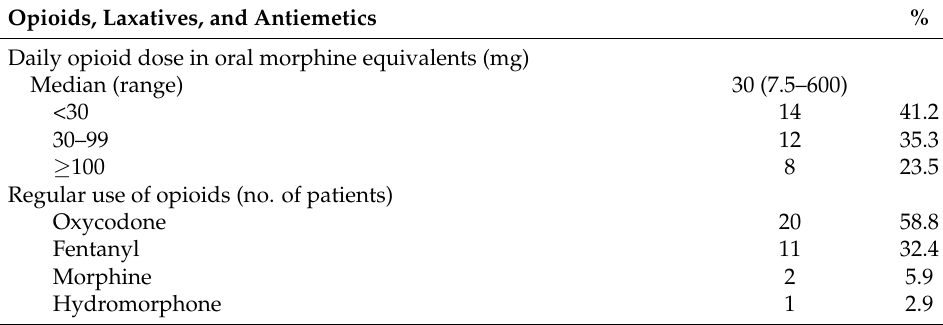
Table 2. Opioids, laxatives, and antiemetic drugs used in this study. Opioids, Laxatives, and Antiemetics Daily opioid dose in oral morphine equivalents